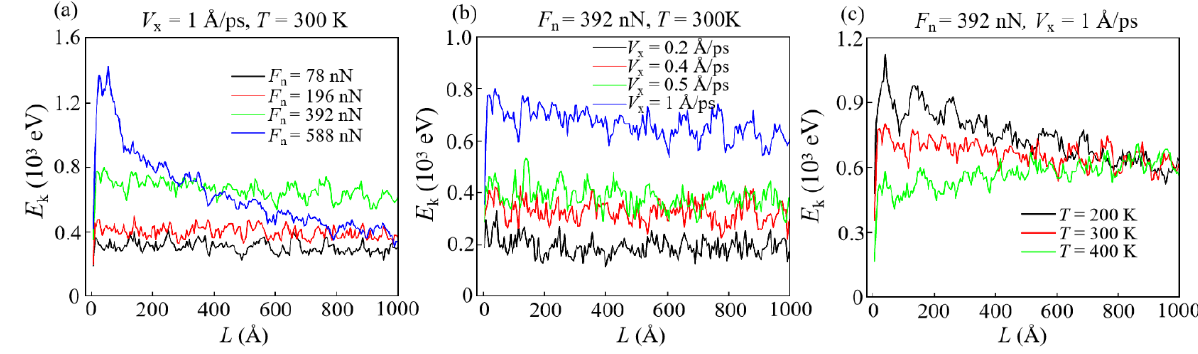
Figure 10. The evolution of the kinetic energy E k under different conditions: ( a ) V x = 1 Å/ps, T = 300 K; ( b ) F n = 392 nN, T = 300 K; ( c ) F n = 392 nN, V x = 1 Å /ps.